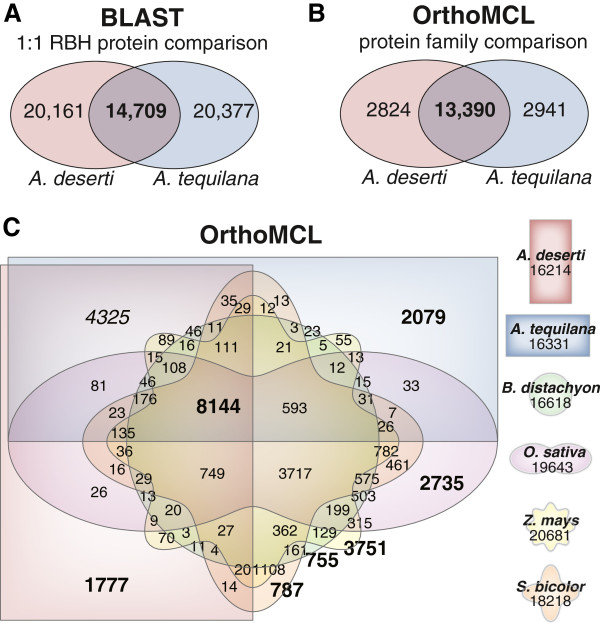
Comparison of inferred proteomes of agaves and additional plant species. (A) Diagram of BLASTP-based 1:1 reciprocal best hit (RBH) proteins shared between agaves.(B) Diagram of OrthoMCL-defined protein families shared between agaves. (C) Diagram of OrthoMCL-defined plant orthologous-group protein families (Plant OGs) shared between agaves and 4 additional monocotyledonous plant species. Shape and color used for each species is noted with the total number of Plant OGs within each species.